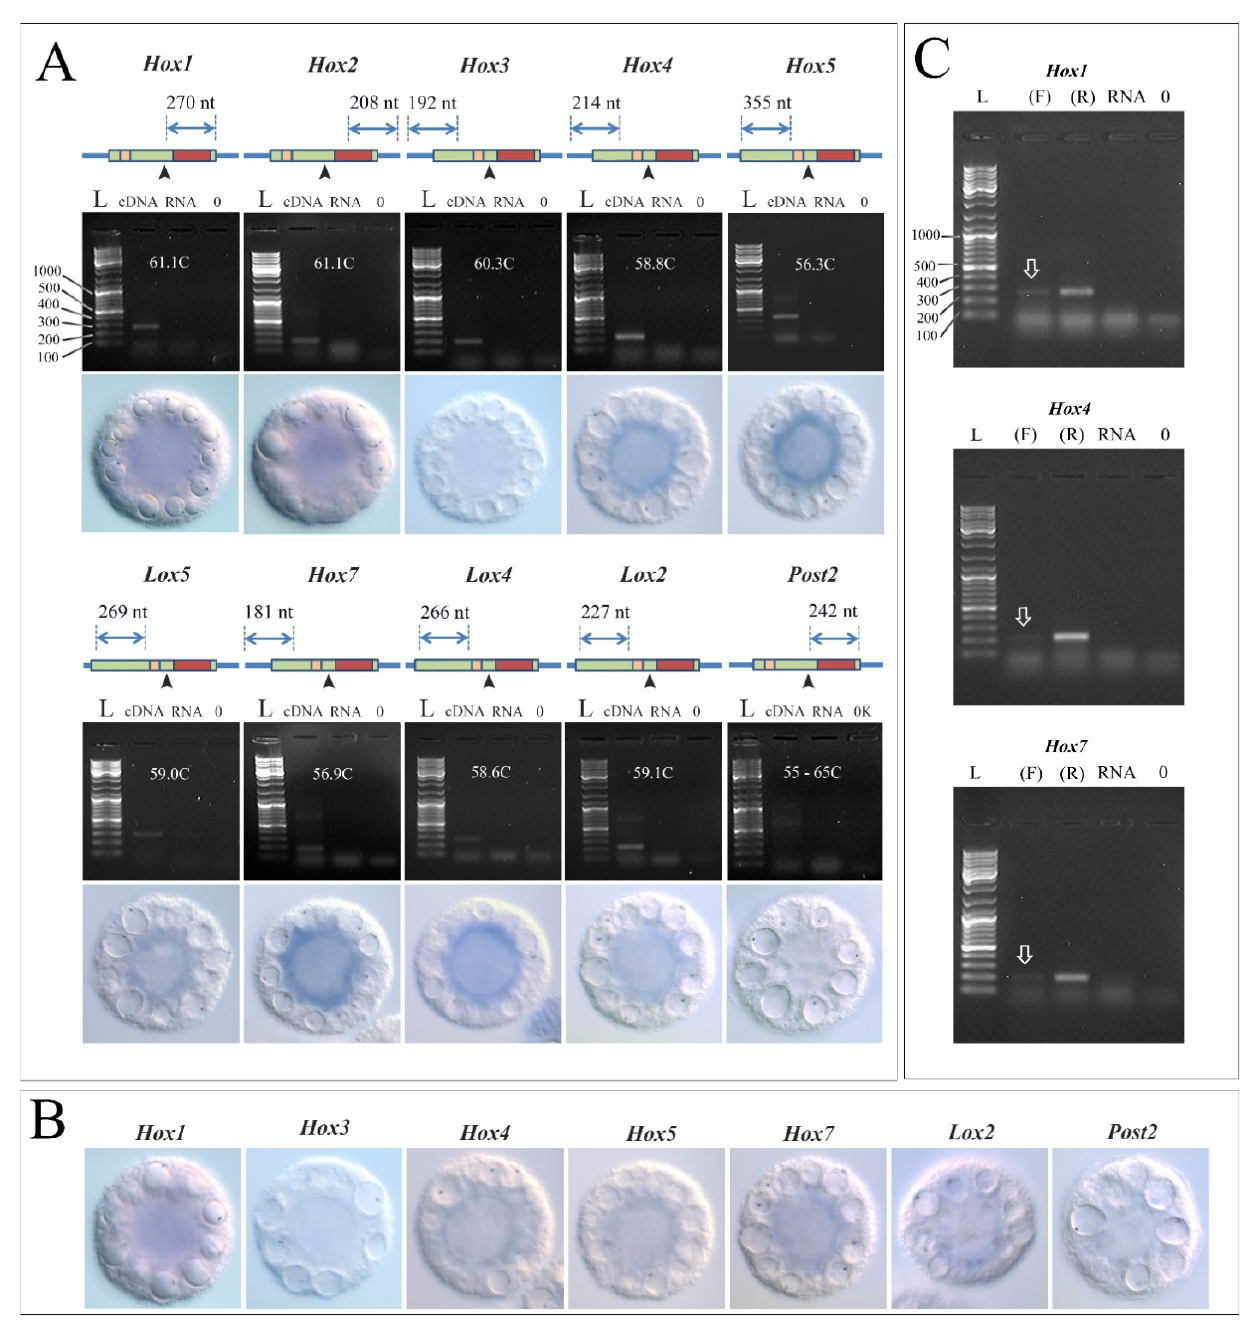
Figure 1. RT-PCR and in situ hybridization results for ten Pdum Hox genes. ( A ) Results of RT-PCR and in situ hybridization with antisense Dig-probes to Hox transcripts. Schematic projection of primers onto Hox transcripts. The expected size of the PCR-fragments is indicated above the double-headed arrow. Red rectangle—homeobox; yellow rectangle—hexapeptide sequence; coding region is marked in green, 5 ′ (left) and 3 ′ (right) UTRs are marked in blue; the black arrowhead indicates the position of the intron. Scaling between amplified fragments and gene sizes is not respected in the schemes. cDNA from oocytes was obtained using random primers. L-Ladder (GeneRuler DNA Ladder Mix); RNA—genomic DNA control; 0—zero control, where water was used instead of the matrix. The white numbers indicate the annealing temperature. The additional high bands visible at the 800 bp level are not a product of amplification because they are present in the control samples that do not contain Taq-pol (Supplementary Figure S2). ( B ) Results of in situ hybridization with sense Dig-probes. ( C ) Strand-specific RT-PCR. L—Ladder, (F)—Forward primer; (R)—Reverse primer; 0—zero control. White arrows mark bands synthesized from antisense transcripts.